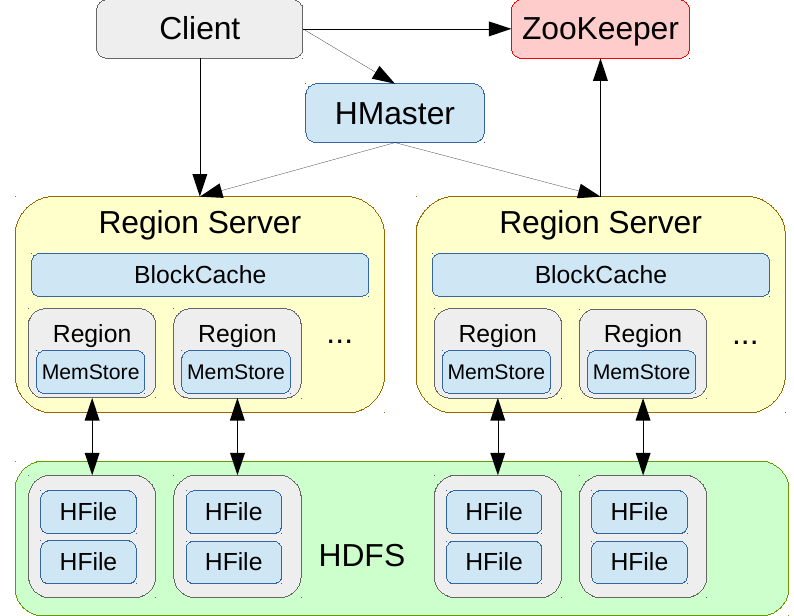
Figure 3. Deployment of an HBase column store cluster.